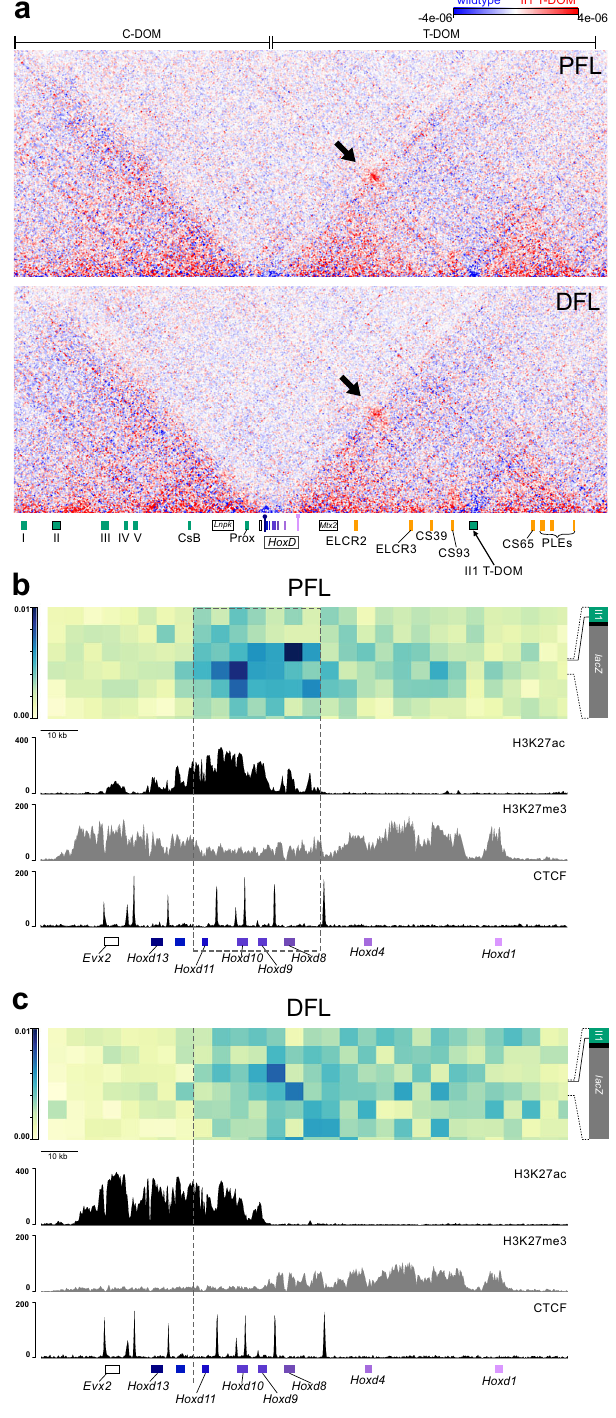
subtraction of the mutant contact signal from the wild type (Fig. 6a, black arrows; Supplementary Fig. 6, black arrows). This gain of contacts between the recombined II1 enhancer and the HoxD cluster in both proximal and distal cells, were the only noticeable change induced by the presence of the transgene on the general chromatin con fi guration of the locus (Fig. 6a). In order to evaluate these new contacts in greater detail, we plotted pairwise heatmaps between the HoxD cluster and II1 T- DOM, as well as H3K27me3, H3K27ac, and CTCF ChIP-seq datasets 23,32 .